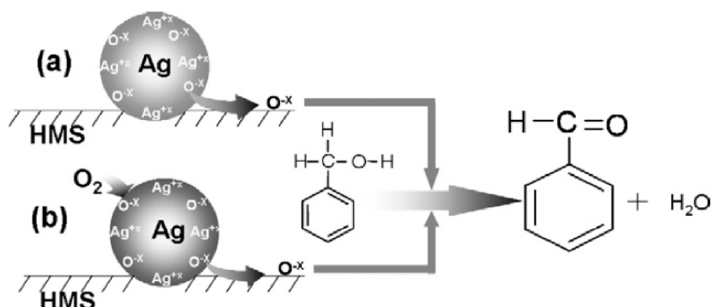
Figure 4. Catalytic mechanism illustration for selective oxidation of benzyl alcohol to benzaldehyde on Ag-HMS catalyst. Reproduced from Ref. with permission from the Elsevier. Reprinted with permission from reference [70]. Copyright 2012 Elsevier.